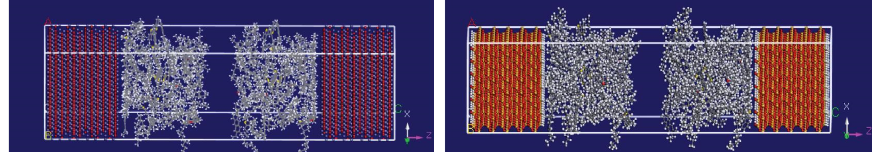
Figure 6: Layer structures for Fe